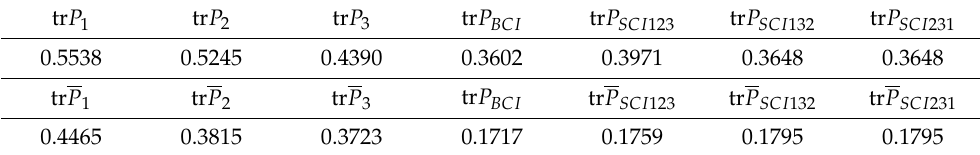
Table 3. The accuracy comparison of local and fused robust time ‐ varying Kalman filters at 10 t  .